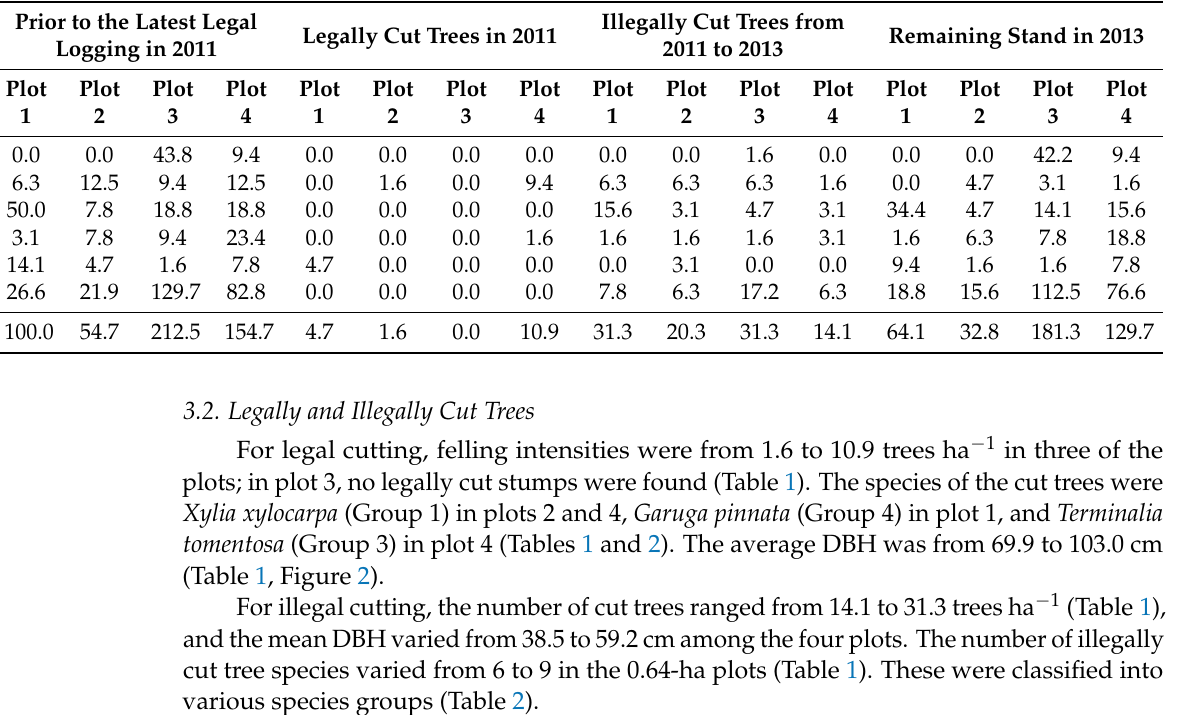
Figure 2. Diameter at breast height (DBH) distribution prior to the latest legal logging for commercial species groups in the four plots for plots 1 to 4 ( a – d ). Table 2. Tree density (ha − 1 ) for each species group before and after the latest legal logging in 2011, and legally and illegally cut tree in four